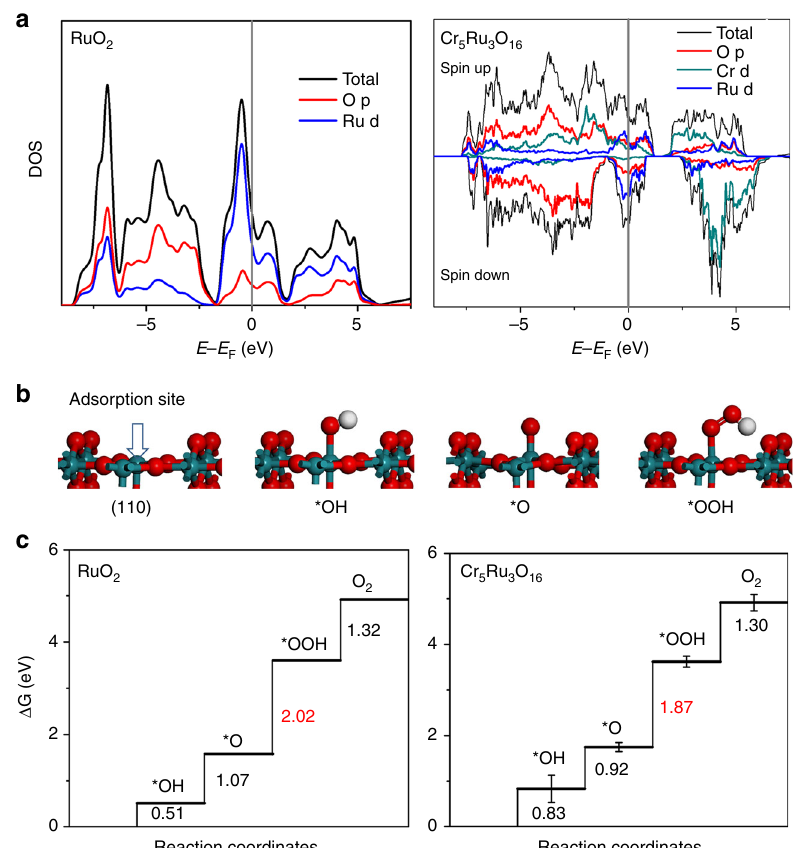
Fig. 8 DFT calculations on the studied CrO 2 -RuO 2 solid solution system. a DOS of RuO 2 and Cr 5 Ru 3 O 16 ; b The four-step OER process; c The calculated free energy diagrams for RuO 2 and Cr 5 Ru 3 O